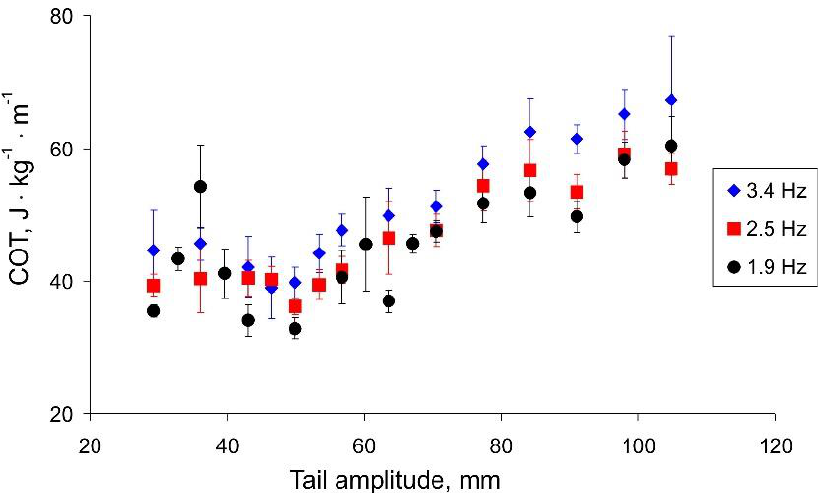
Figure 7. The cost of transport (COT) vs. the tail amplitude.